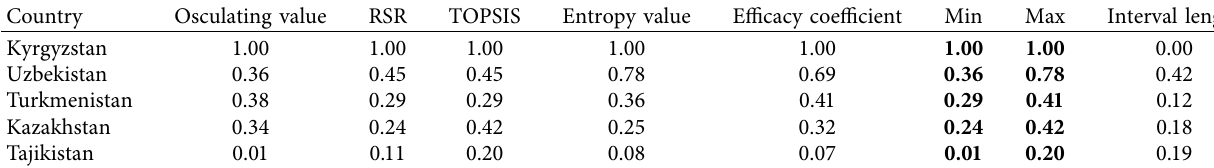
Table 5: Matching result of Chinese power companies in Central Asia.